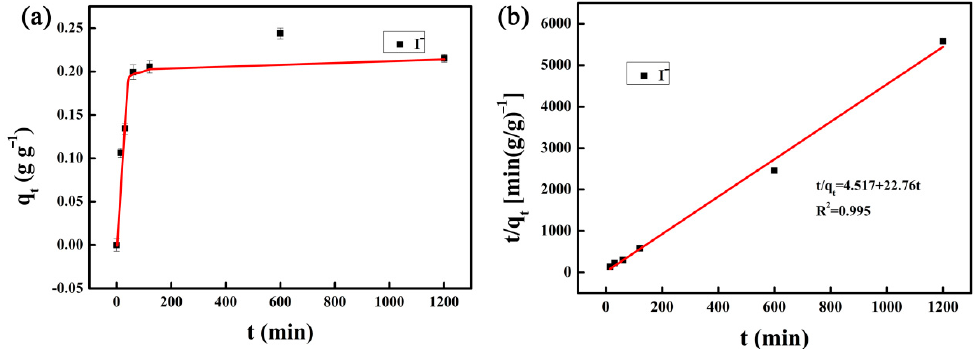
Figure 3. ( a ) The effect of contact time on the I − adsorption on Ag + @UiO-66-(COOH) 2 ; ( b ) pseudo- second-order plots of the time-dependent I − adsorption.